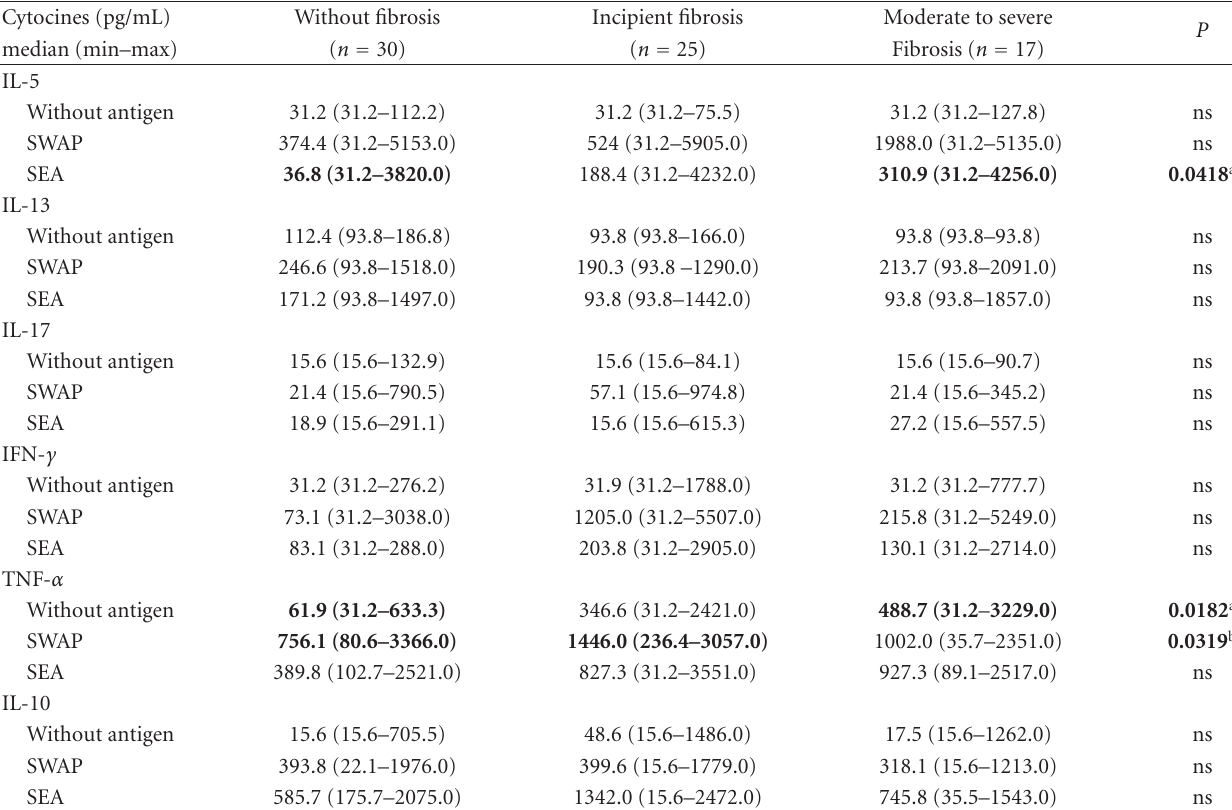
Table 2: Levels of cytokines produced by peripheral blood mononuclear cells (PBMC) of studied